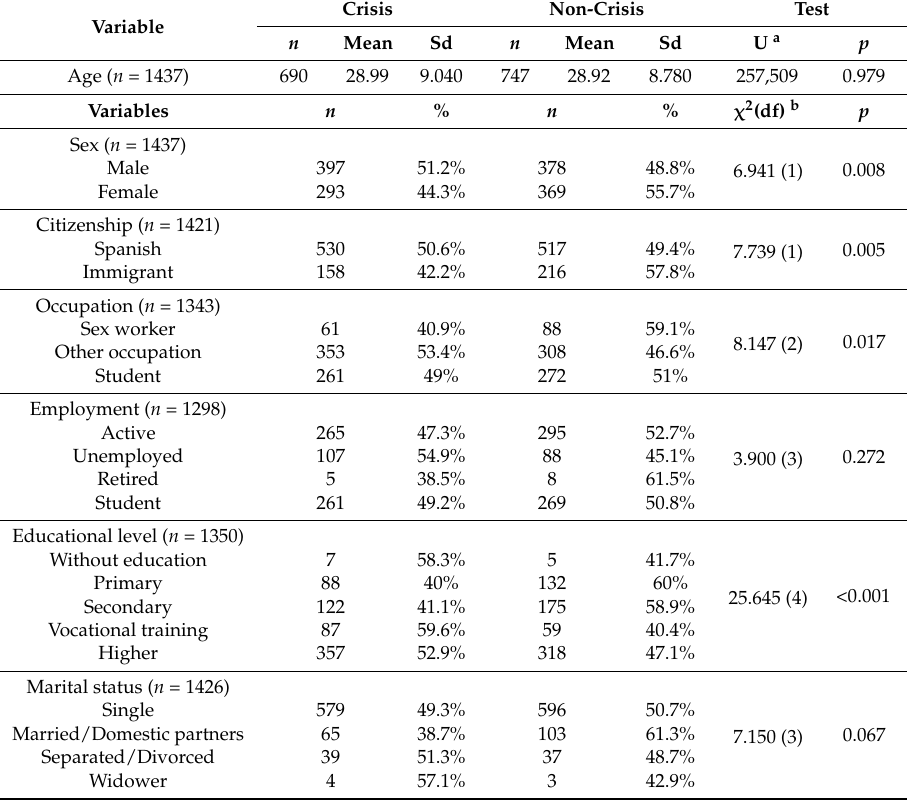
Table 1. Sociodemographic Characteristics during the Crisis vs. Non-crisis Periods.